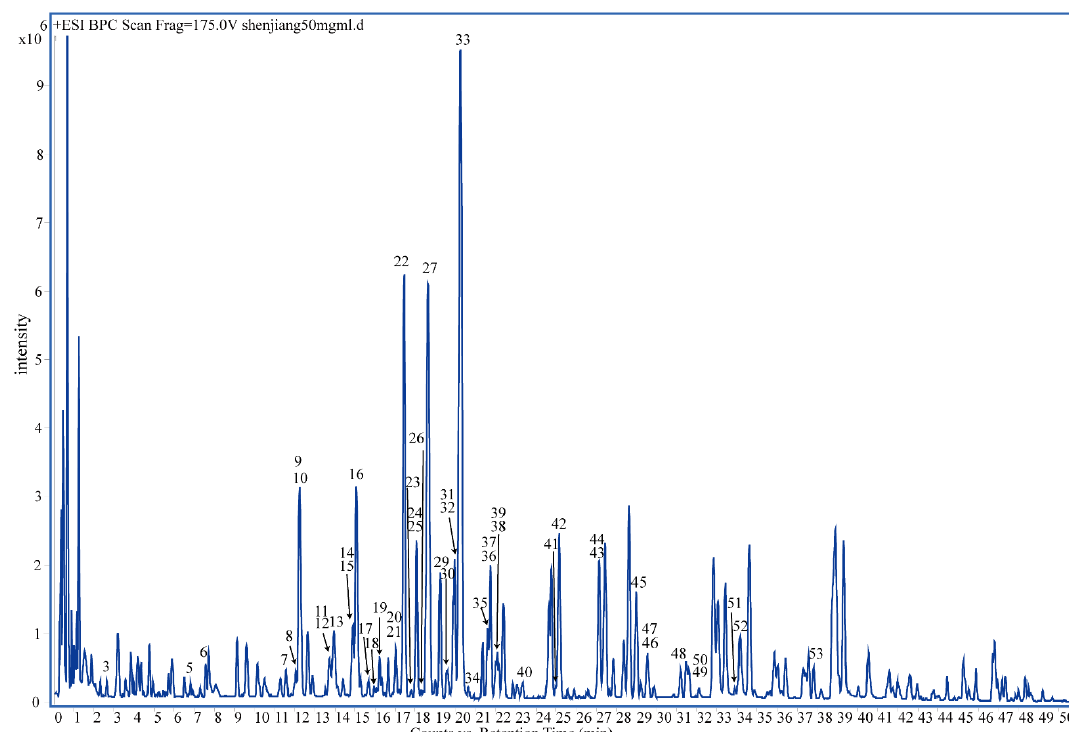
Figure 1. (+)-ESI base peak chromatogram (BPC) of the dried ginger water extract by UHPLC–ESI- QTOF-MS.